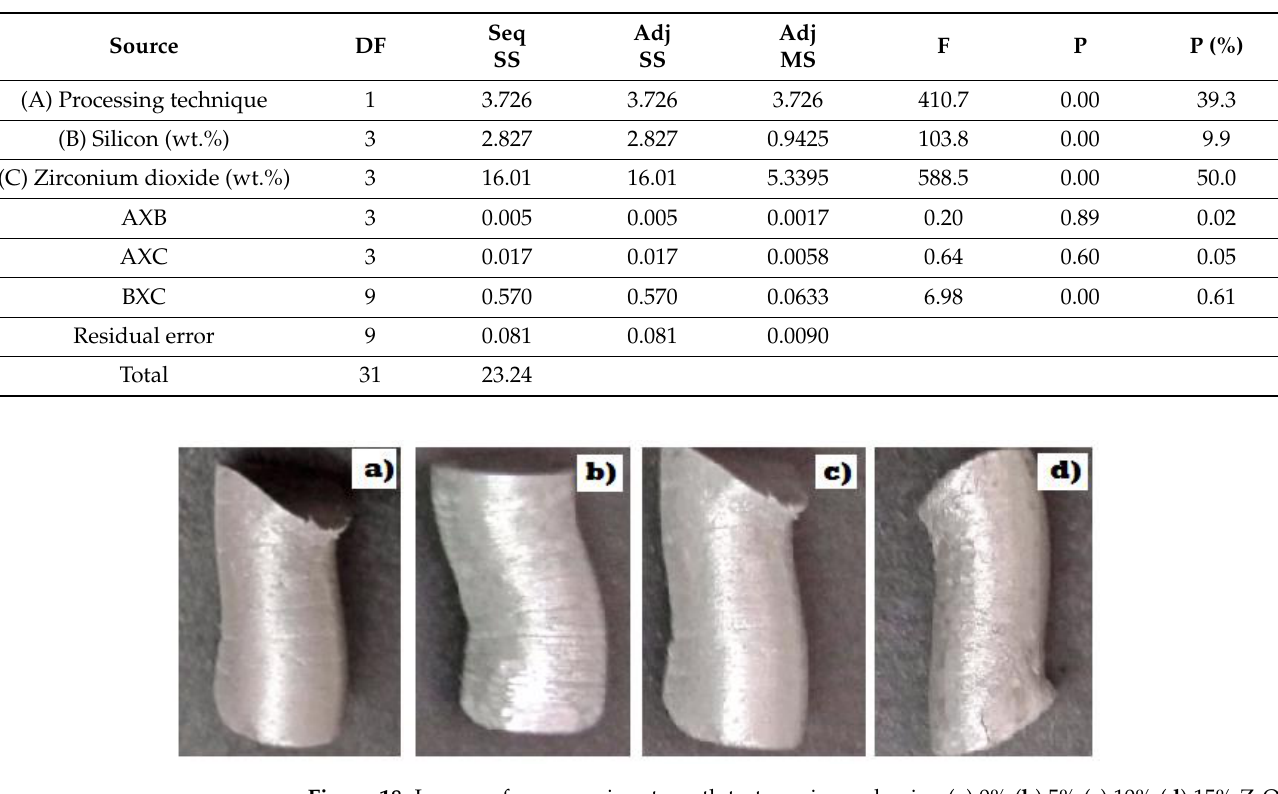
Figure 20. Tensile strength interaction plot. Figure 21. Tensile strength contour plot at zirconium dioxide–silicon planes. From the main effects plot Figure 22 for tensile strength,the optimum processing conditions for the tensile strength can be established at processing technique (A): spray forming, silicon wt.% (B): 13 wt.%, zirconium dioxide wt.% (C): 15 wt.%.